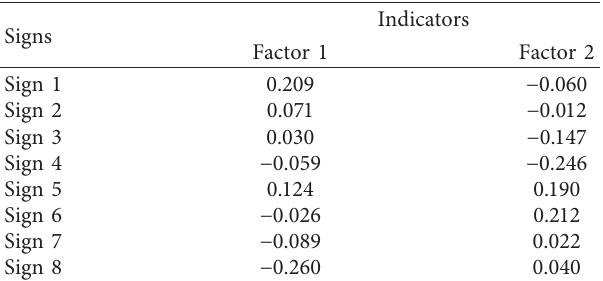
Table 9: Normalized matrix Y .